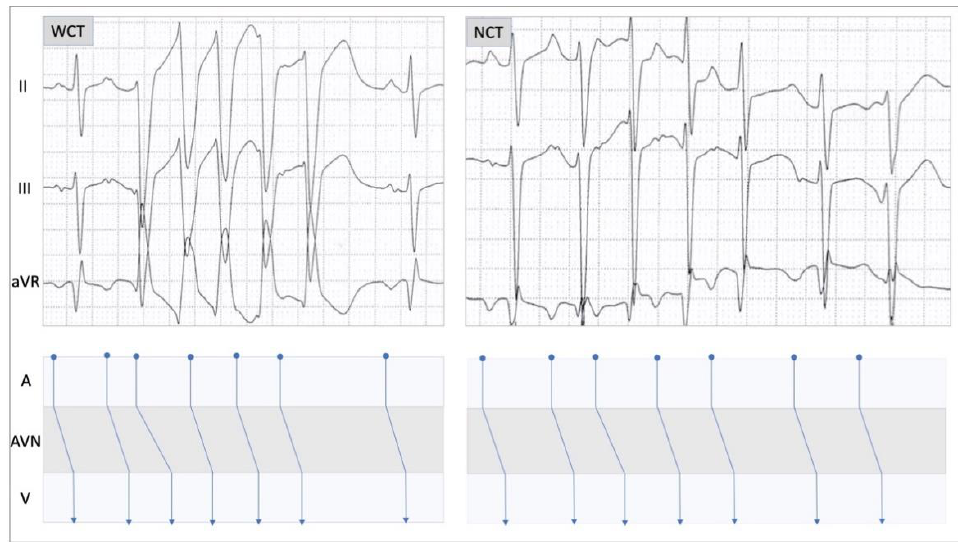
Figure 3. Ladder diagram illustrating the mechanism of conduction at the level of the atria (A), atrioventricular node (AVN), and ventricles (V). The left panel displays an episode of wide complex tachycardia (WCT) and the right panel shows an episode of narrow complex tachycardia (NCT). Note that both episodes start with a premature atrial contraction-conducted anterogradely via the AVN.